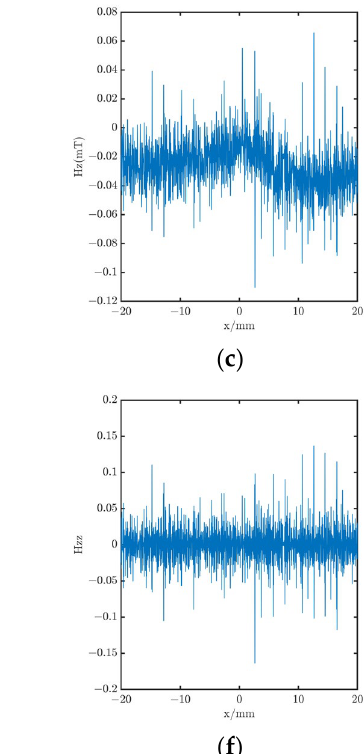
Figure 1. Enhanced metal magnetic memory testing system and specimen diagram. ( a ) Q235 specimen. ( b ) Enhanced metal magnetic memory testing system.